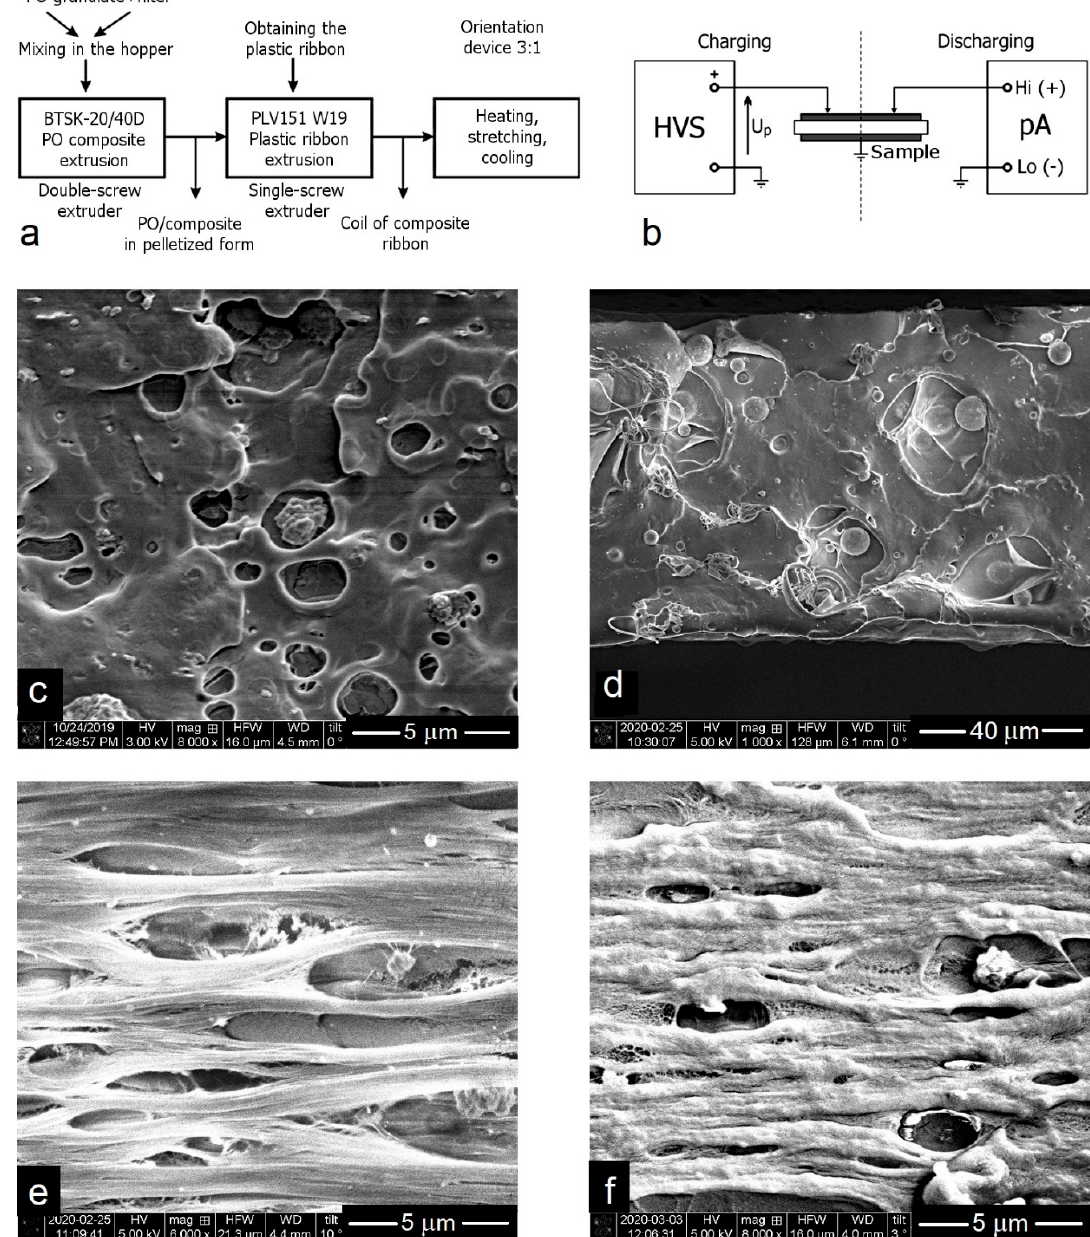
Figure 2. ( a ) Diagram of the technological process of composite manufacturing; ( b ) scheme of the film polarization and depolarization process; ( c – f ) representative SEM images of the selected oriented and non-oriented composite films (internal morphology visualized by a brittle fracture of film): ( c ) I-PP with 10 wt% of P87, non-oriented, ( d ) i-PP with 10 wt% glass beads, non-oriented, ( e ) i-PP with 5 wt% P87, oriented, ( f ) HDPE with 5 wt% P87, oriented.